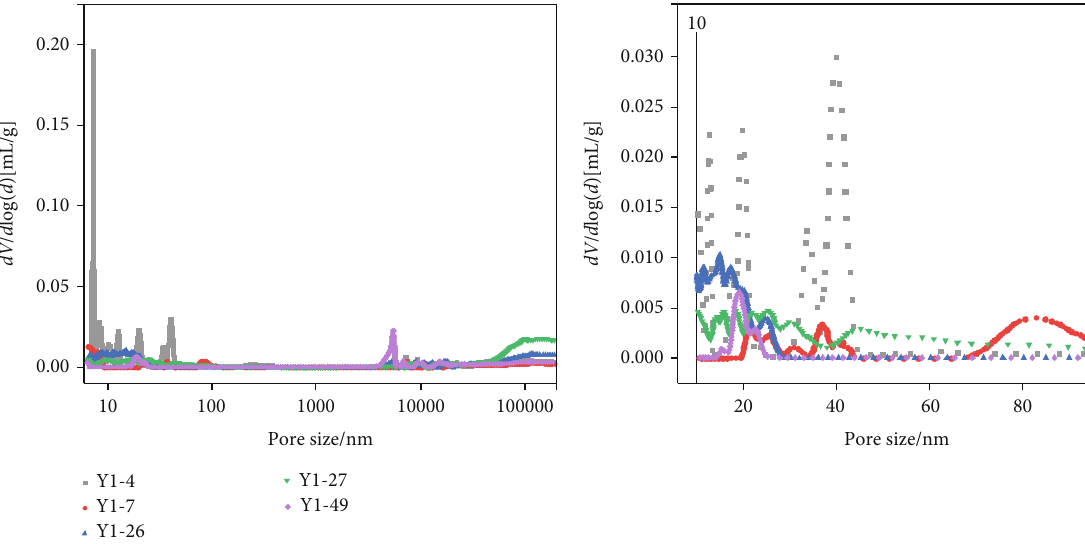
Figure 7: Pore size distribution of shale samples.